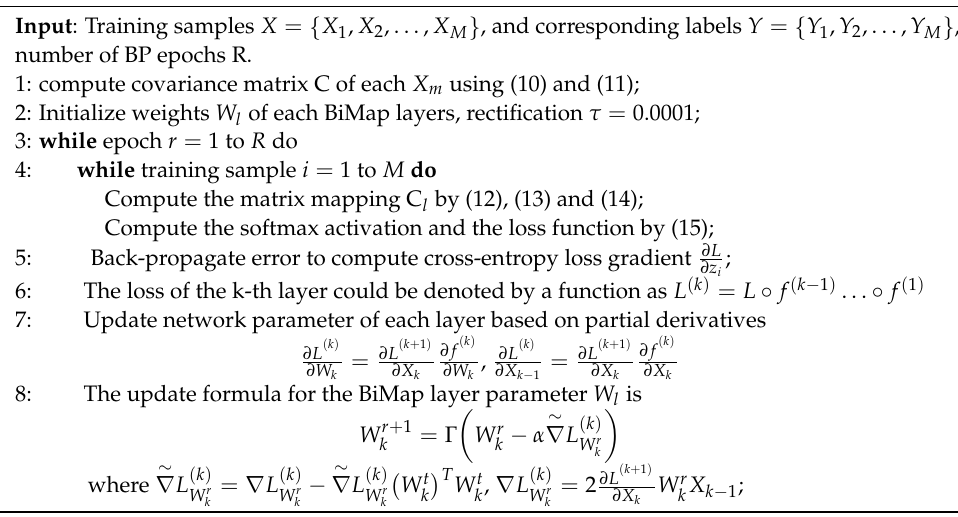
Algorithm 2 Manifold Network